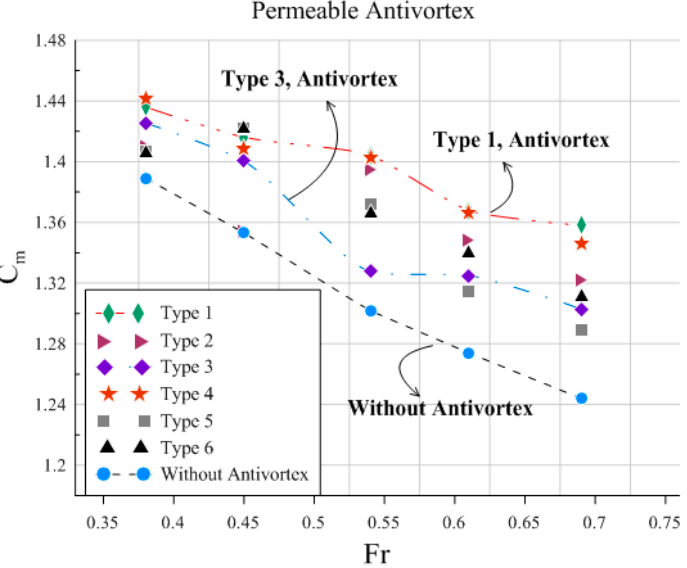
Figure 10. Variations in C d with Fr in the triangular labyrinth side weir with and without anti- vortexes.